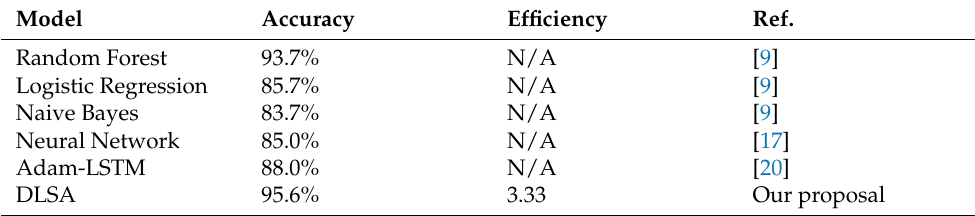
Table 1. Performance comparison with related